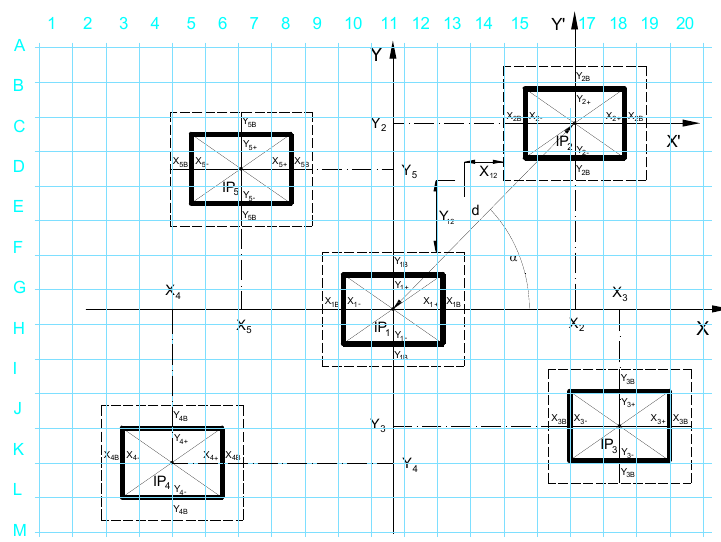
Figure 3. Model of building elements relationships of production systems 1 - α [28].